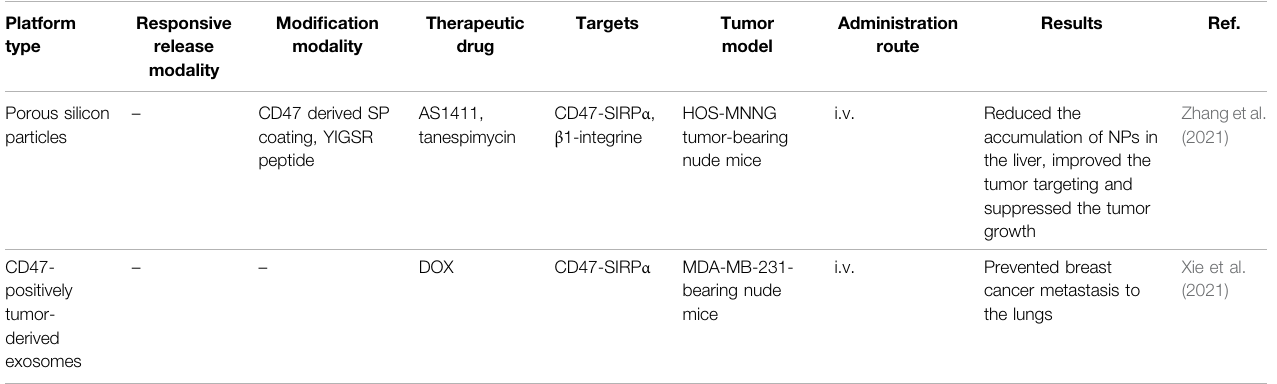
Frontiers in Bioengineering and Biotechnology |